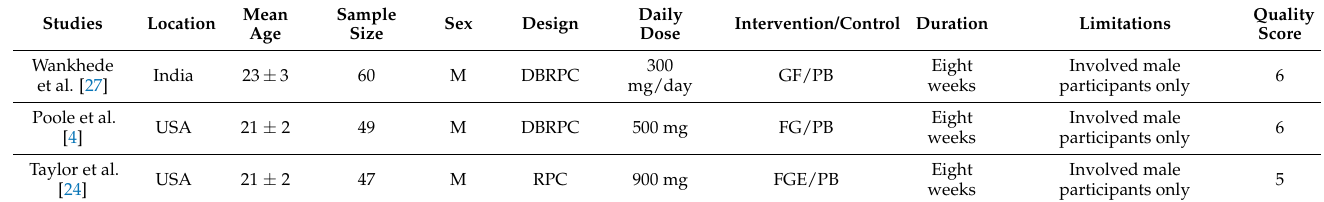
Table 1. Summary of the included